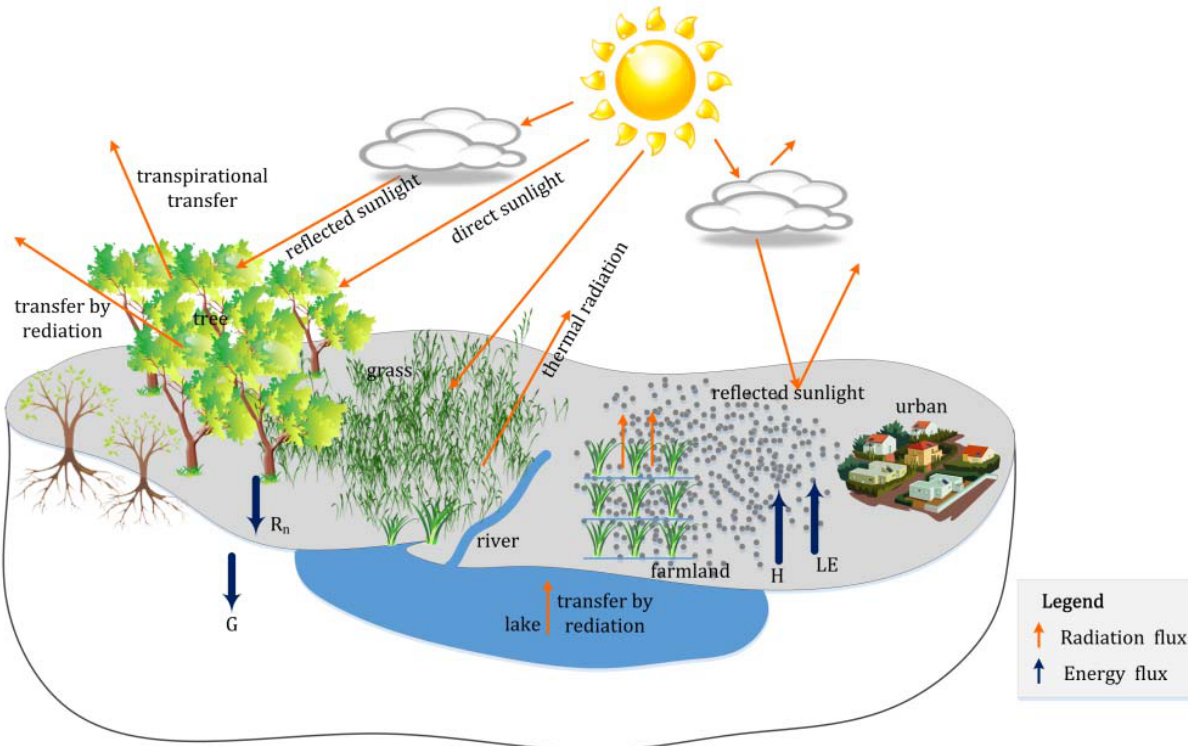
Figure 4. Diagram of the energy